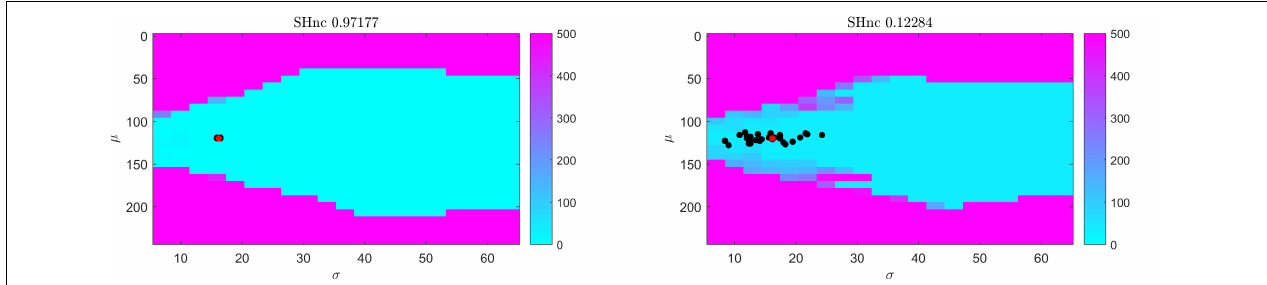
FIGURE 3 | Results of the convergence of the optimization of a one simulated dimensional pRF characterizing the preference to sound frequencies (i.e., auditory fMRI data; high (left) and low (right) split-half noise ceiling). Colors indicate the distance (squared Euclidean norm) between true parameter values (red dot) and the solution obtained from starting Levenberg-Marquardt optimization at each location in parameter space. Distance values are averaged over 30 realizations. Black dots indicate the initial conditions (for pRF estimation using LMA) estimated from grid-search. In particular a cyan color indicates the starting values for pRF mean and size that resulted in the Levenberg-Marquardt algorithm to converge to the simulated value.